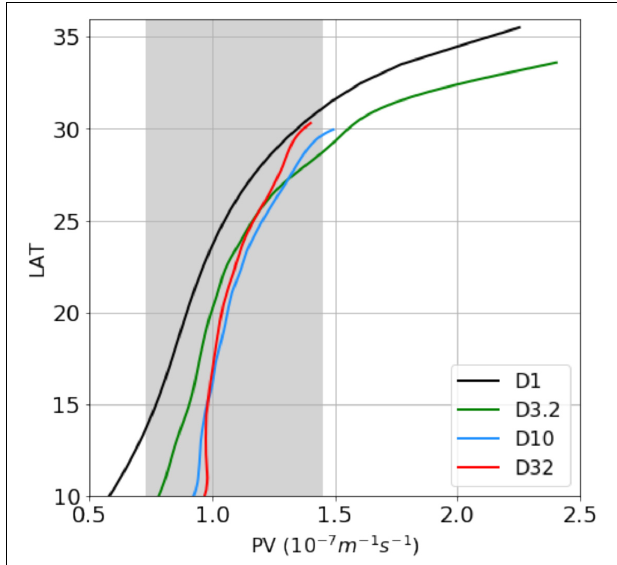
FIGURE 9 | The columnar PV, zonally averaged between 10 ◦ E and 40 ◦ E, and plotted against latitude spanning the subtropics. These four lines terminate at the outcrop latitude, and the gray region indicates the range of the homogenized PV calculated from the PV